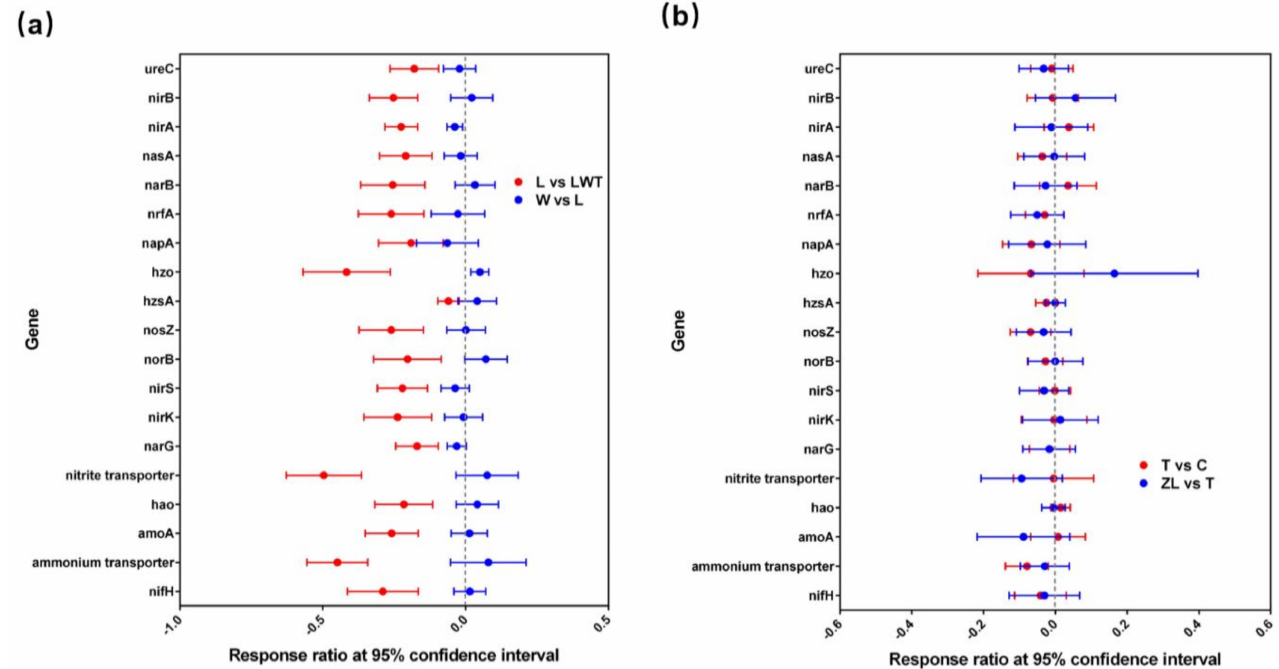
Figure 9. The response of N cycling-related genes to degraded and restored/natural wetland sites as per GeoChip data. ( a ) RRs are presented as the difference between lightly degraded and severely degraded Phragmites marsh sites (red symbols), and between restored and lightly degraded Phragmites marsh sites (blue symbols). ( b ) RRs are presented as the difference between the natural and degraded Carex marsh sites (red symbols), and between the two natural Carex marsh sites (blue symbols). The RR is considered significant when the 95% confidence interval (presented as error bars) does not overlap with 0. The abbreviations present restored (W), lightly degraded (L), and severely degraded (LWT) Phragmites marsh sites, and the natural (T, ZL) and degraded (C) Carex marsh sites,